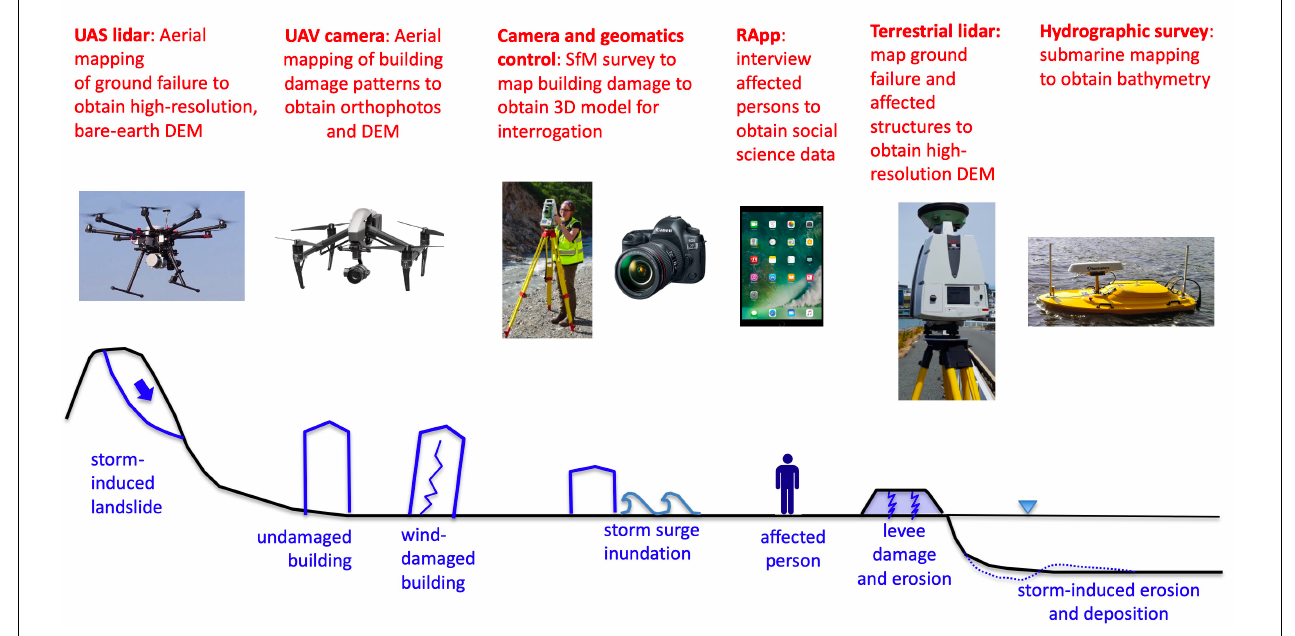
FIGURE 4 | Diagram depicting damage features, secondary effects, and human and societal impacts that commonly result from an extreme wind event. The diagram is similar to Figure 7 , illustrating the commonalities between seismic and wind natural hazard events. Diagrams and inset images are as noted in Figure 7 .